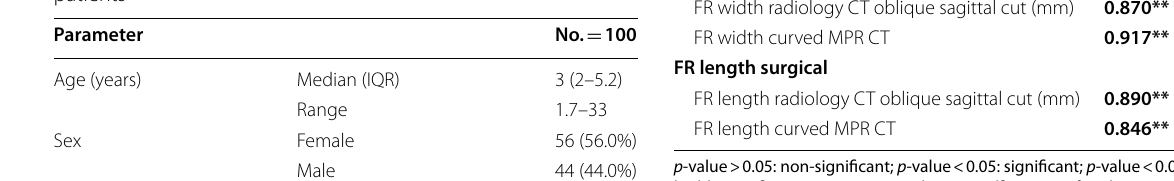
Table 1 Descriptive for demographic data of the studied patients